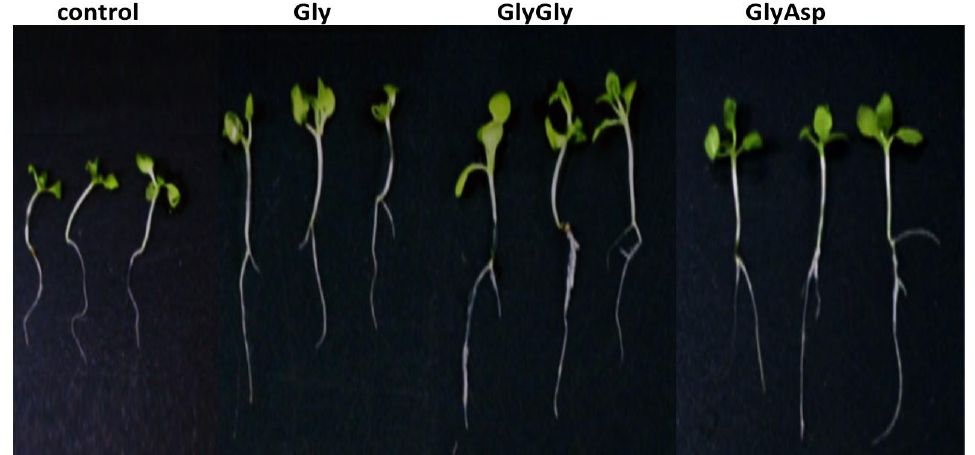
Figure 1. Tobacco seedlings grown on Murashige and Skoog (MS) medium supplemented with or without Gly amino acid and GlyGly and GlyAsp dipeptides. Table 1. Influence of Gly, GlyGly, and GlyAsp on the morphometric parameters of tobacco seedlings.